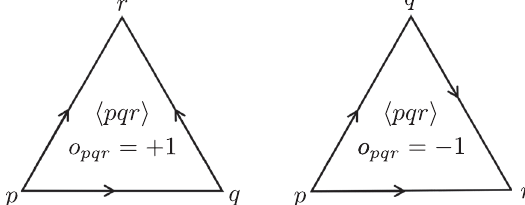
is − 1 or þ 1 pqr